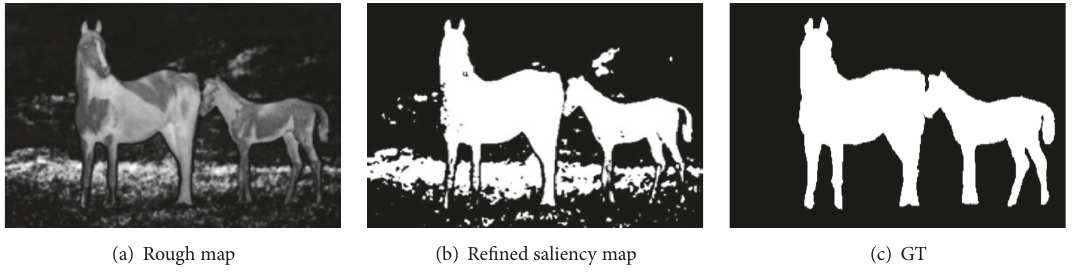
Figure 4: S -measure: (a) rough saliency map is 0.63; (b) refined saliency map is 0.73.